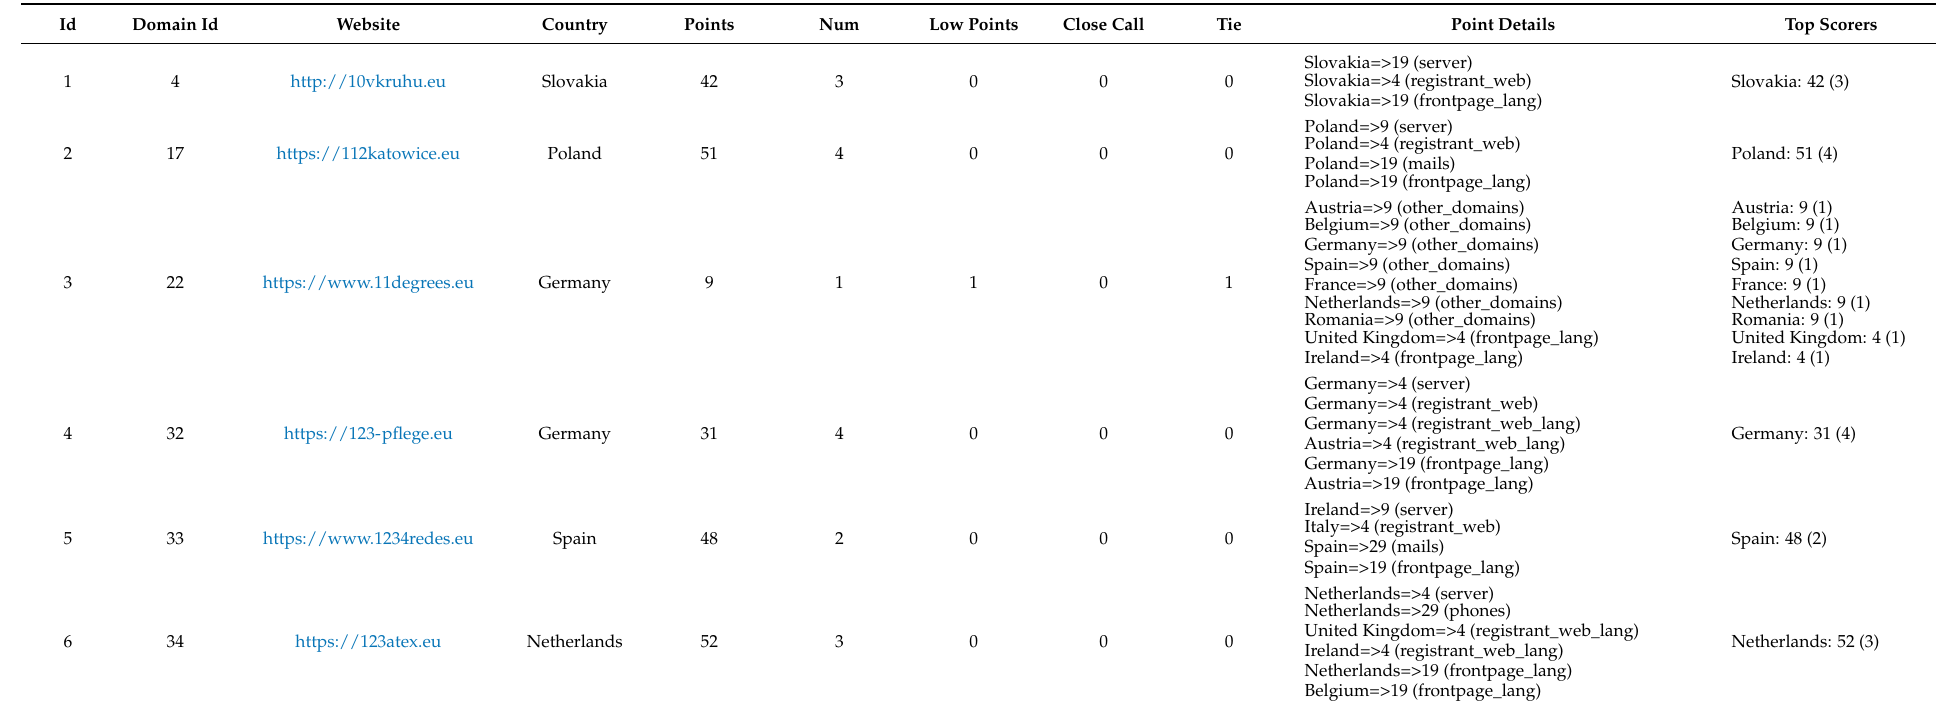
Table 6. Sample of data produced by the detection